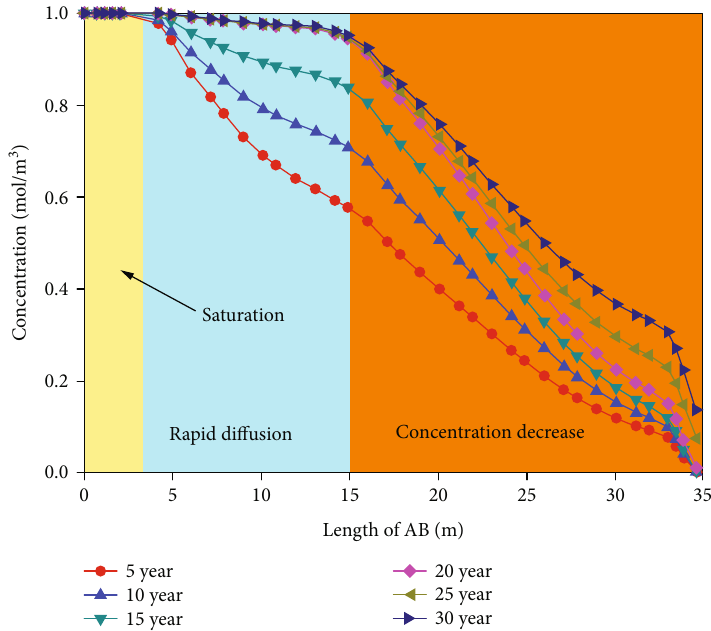
Figure 6: The contaminant concentration along the line of AB in the MF model.